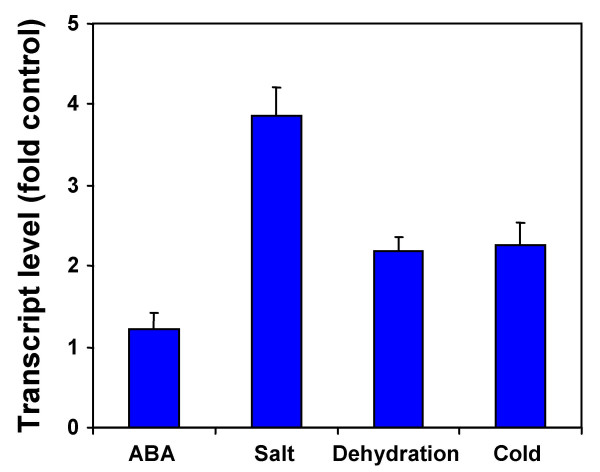
Changes in transcript levels of the OsRR6 gene in response to different stress treatments. The transcript levels of OsRR6 gene in 6-day-old light-grown seedlings treated with ABA, NaCl, mannitol and cold for 6 h, were plotted as the relative expression (fold) of the seedlings mock-treated for the same duration.